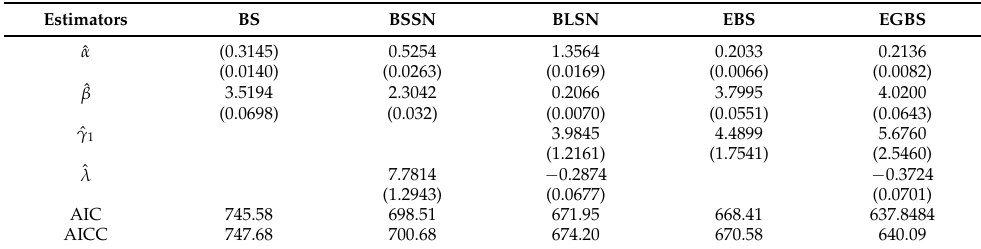
Table 7. Estimated parameters (standard errors) for the fitted